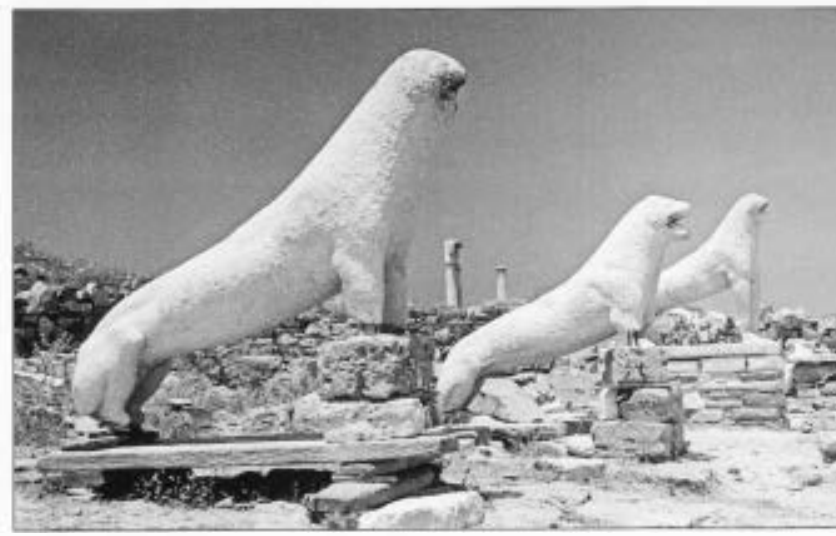
Figure 5 The Portico of the Lions, Delos,